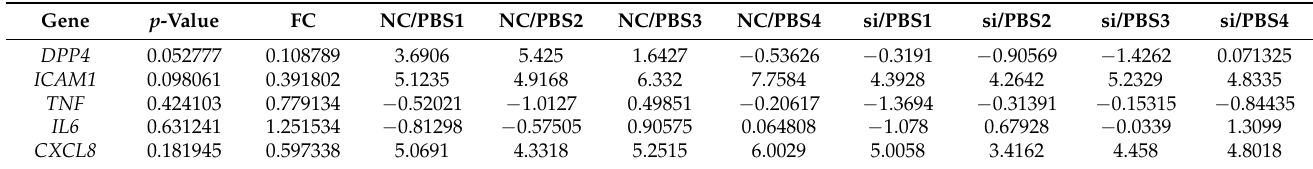
Table 1. Gene expression levels of ARDS-relevant factors (NC/PBS vs. DPP4 siRNA/PBS). Normalized gene signals of each sample are shown in the